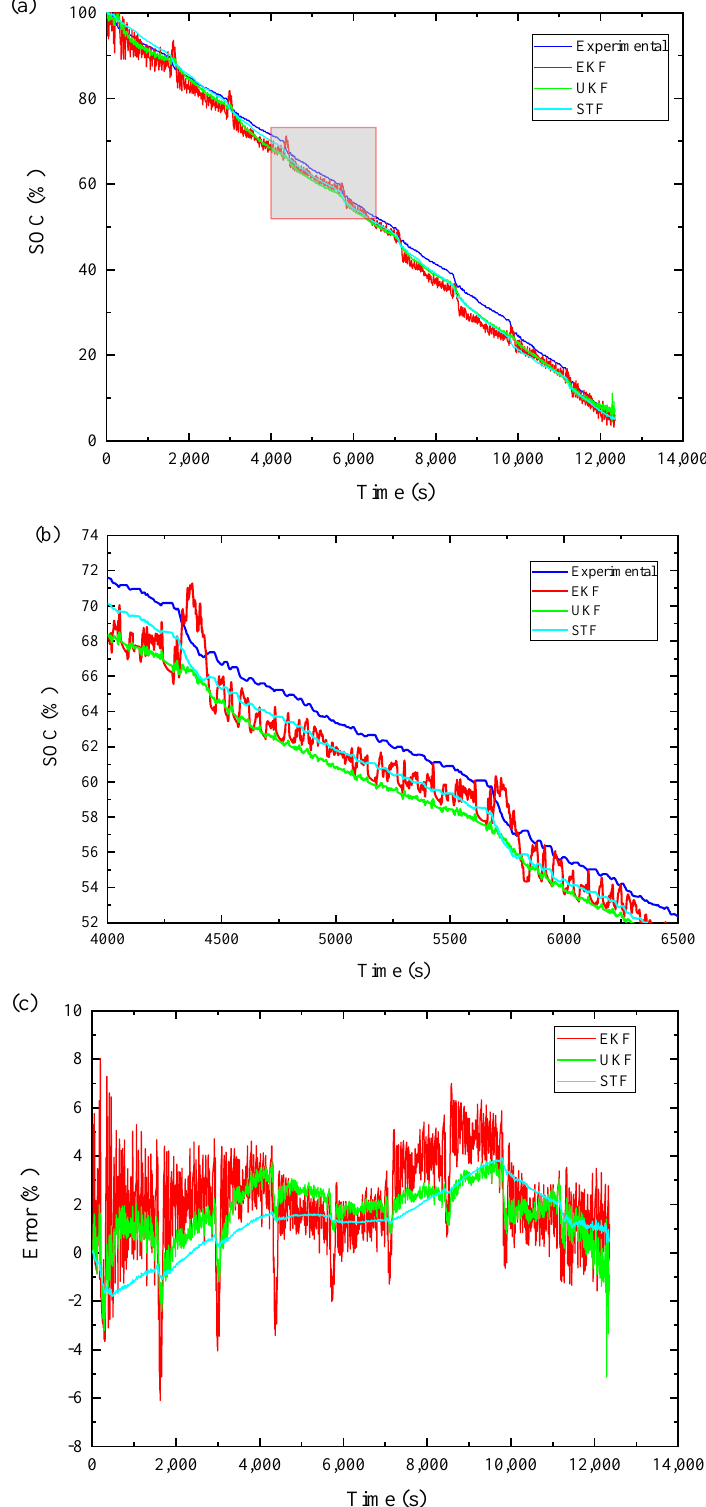
Figure 12. Comparative results of EKF, UKF, and STF for SOC estimation: ( a ) SOC estimation results; ( b ) the enlarged window from 4000 to 6500 s; ( c ) SOC estimation error.